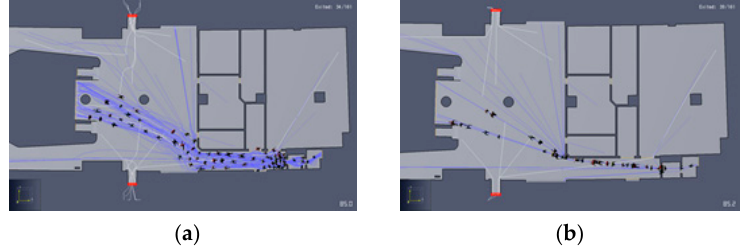
Figure 3. Route results by Simulation Mode: ( a ) steering mode, ( b ) SFPE mode.